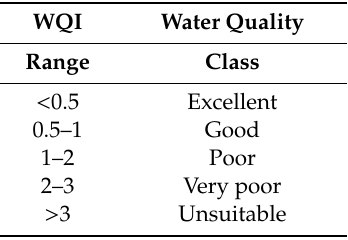
Table 2. Classification of the water quality according to the WQI